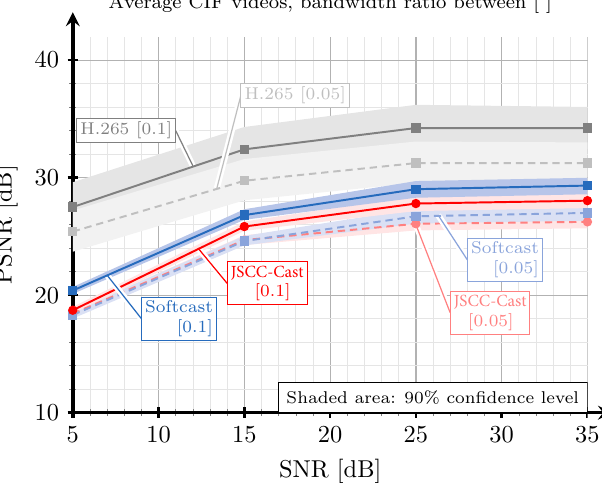
Figure 11. PSNR versus SNR for a selection of videos with CIF resolution extracted from [39]. The red lines correspond to the proposed JSCC-Cast, the blue lines to Softcast, and the grey lines to H.265. The solid lines correspond to a bandwidth ratio of 0.1, and the dashed lines correspond to a bandwidth ratio of